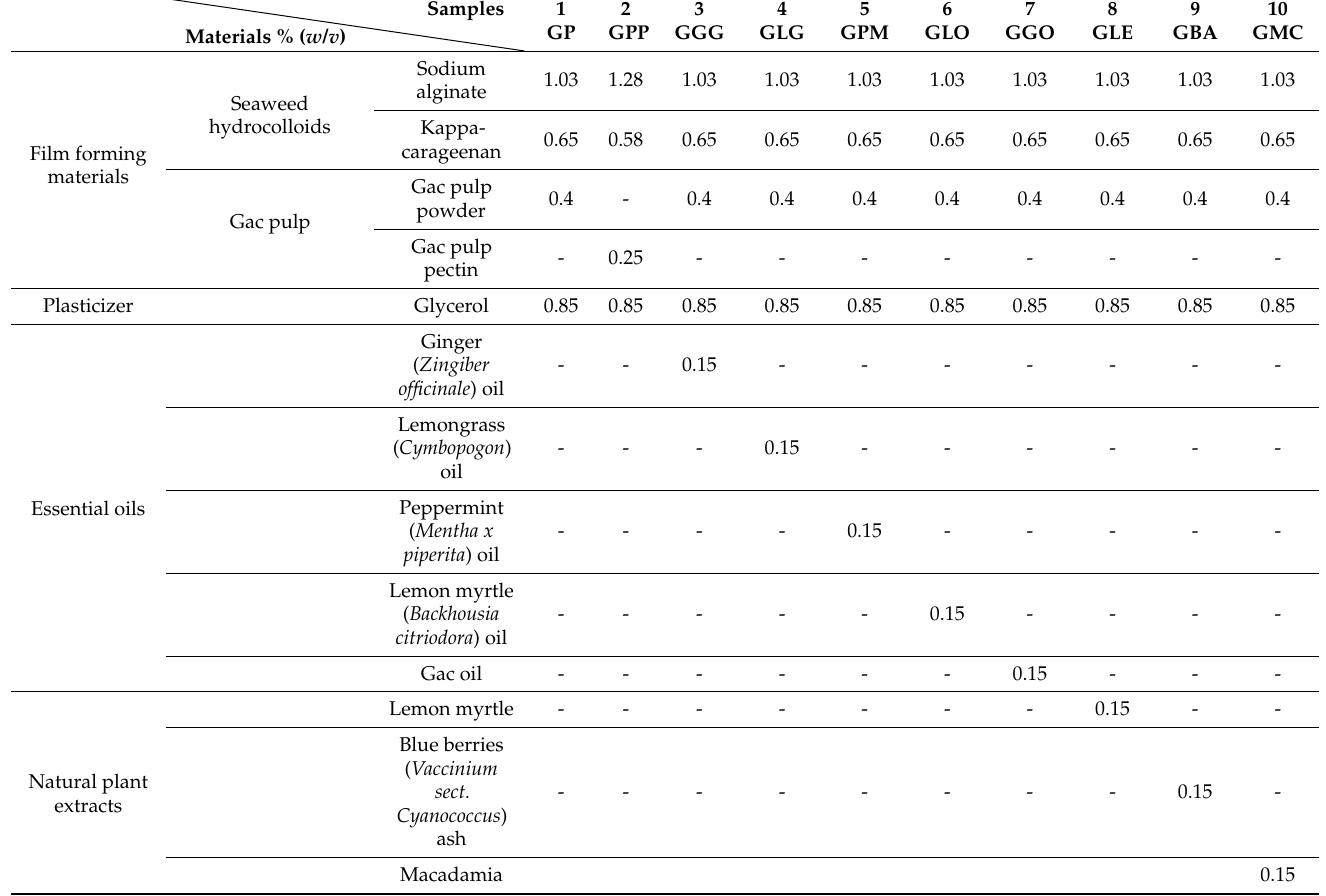
Table 1. Composition of the studied films incorporating essential oils and plant